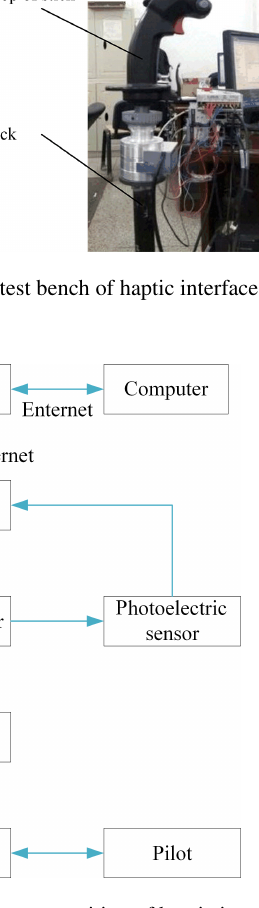
by motor 1 and 2 through the disc reducer respectively; τ f1 and τ f2 are the friction torques on the x axis and y axis of the servo system respectively. The manual force of the pilot in the direction of x axis, y axis and z axis defined as F x , F y , F z .